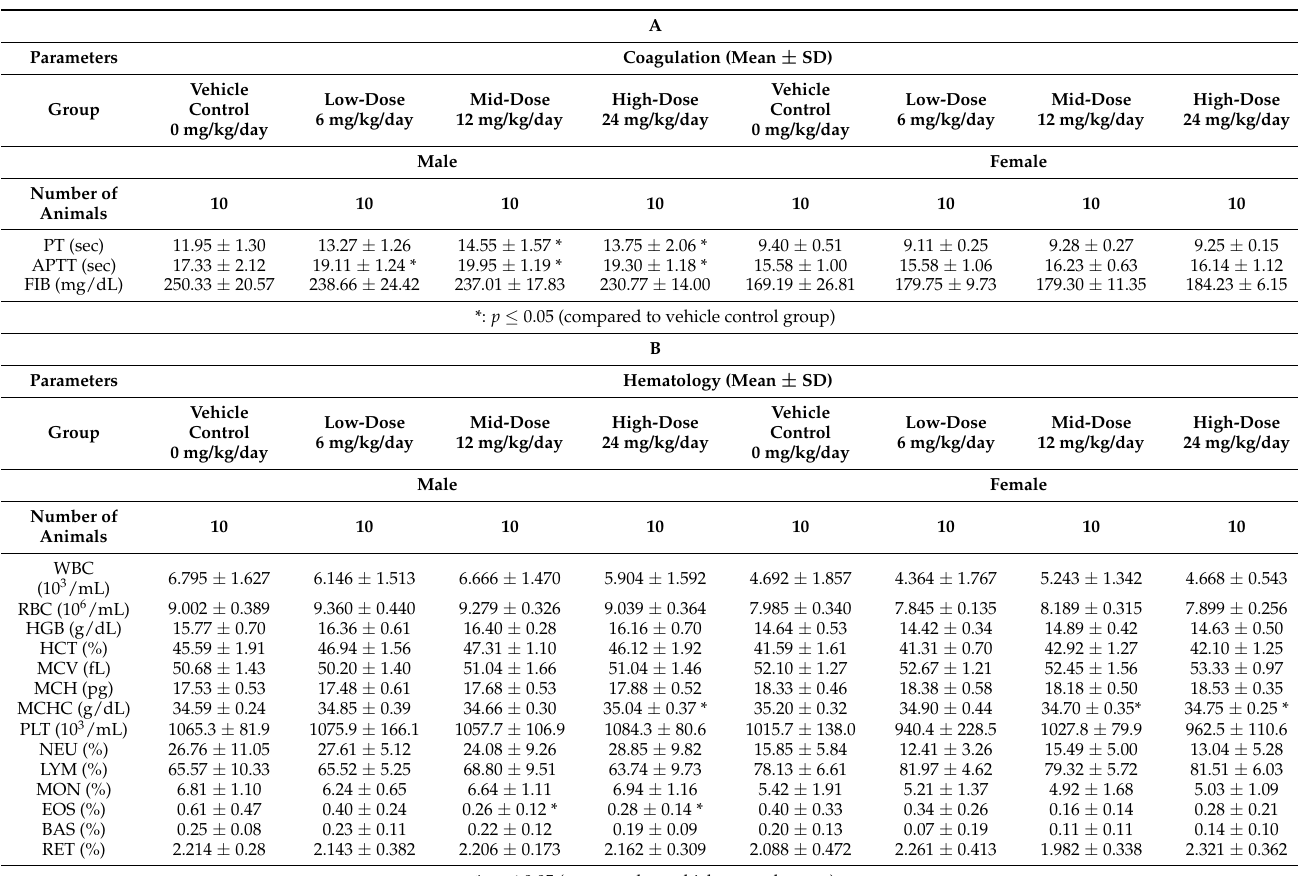
Table 4. (A) Coagulation analysis of rats receiving astaxanthin over a 13-week period. (B) Hematology values of rats receiving astaxanthin over a 13-week period. (C) Serum chemistry of rats receiving astaxanthin over a 13-week period. (D) Urinalysis of rats receiving astaxanthin over a 13-week